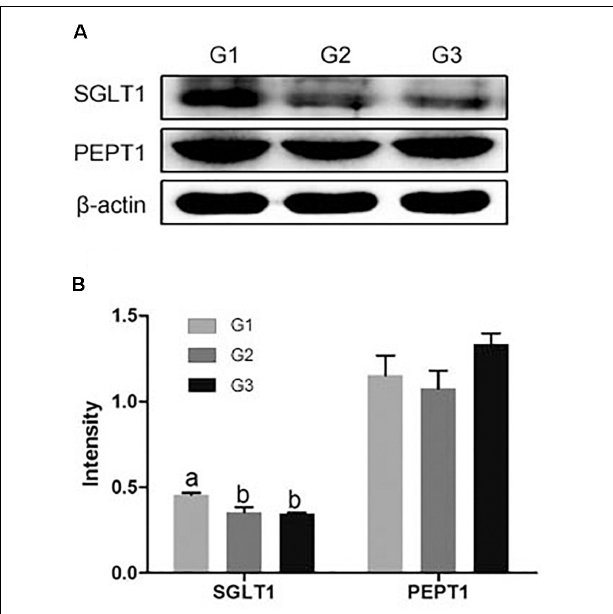
FIGURE 6 | (A) Effects of Ba on the expression of SGLT1 and PEPT1 in jejuna mucosa of piglets. (B) Results were given as mean ± SEM, n = 6. a and b means significantly different ( p <